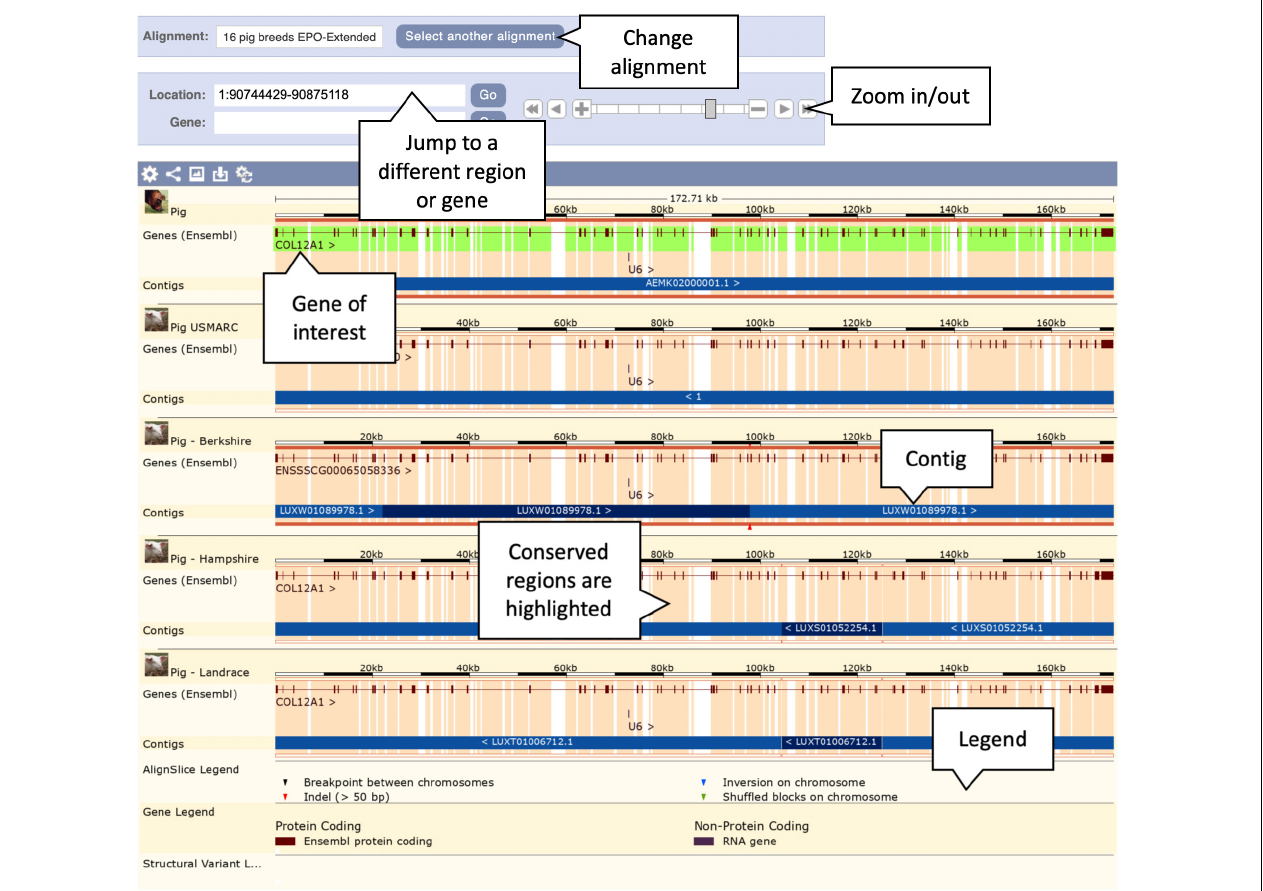
FIGURE 4 | Genomic alignment of pig breeds centred on the COL12A gene. This figure shows only the first five alignments including the reference pig at the top, the complete alignment contains all 13 pig breeds along with cow, horse, and sheep as outgroups. The pale orange highlighting in the background represents conservation. Exonic regions are naturally more conserved across the